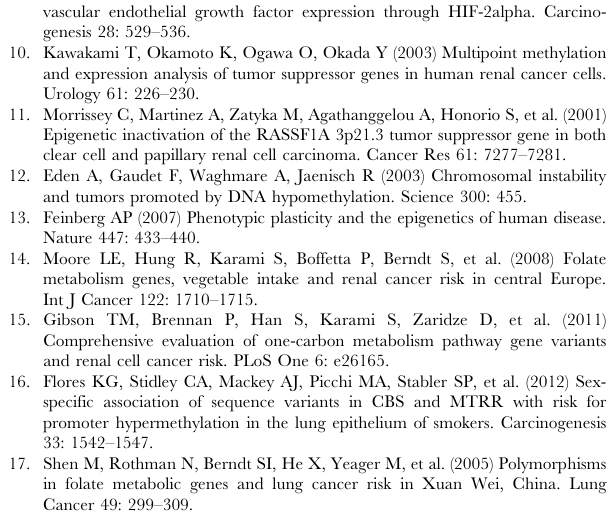
Table S1 All the sequences of primers for each SNP.(DOC). (DOC) Table S2 Polymorphism in one-carbon metabolism genes and clear cell renal cell carcinoma. (DOC).